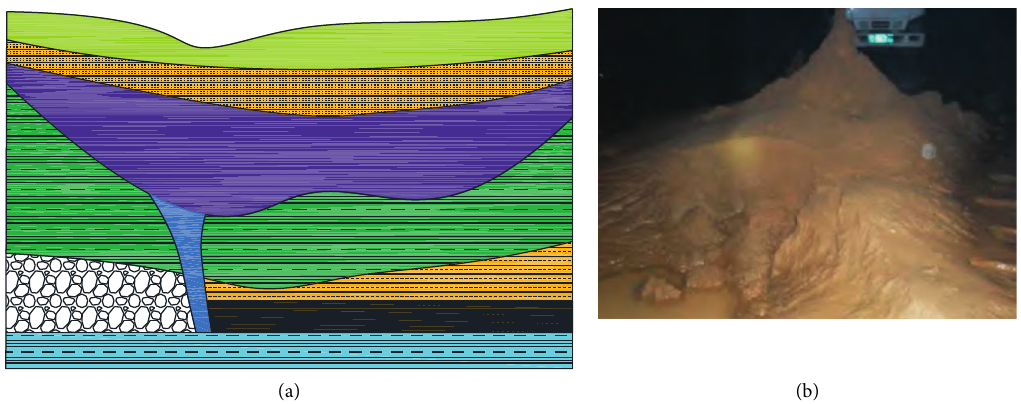
Figure 1: Water and sand inrush. (a) Schematic diagram. (b) Accident site